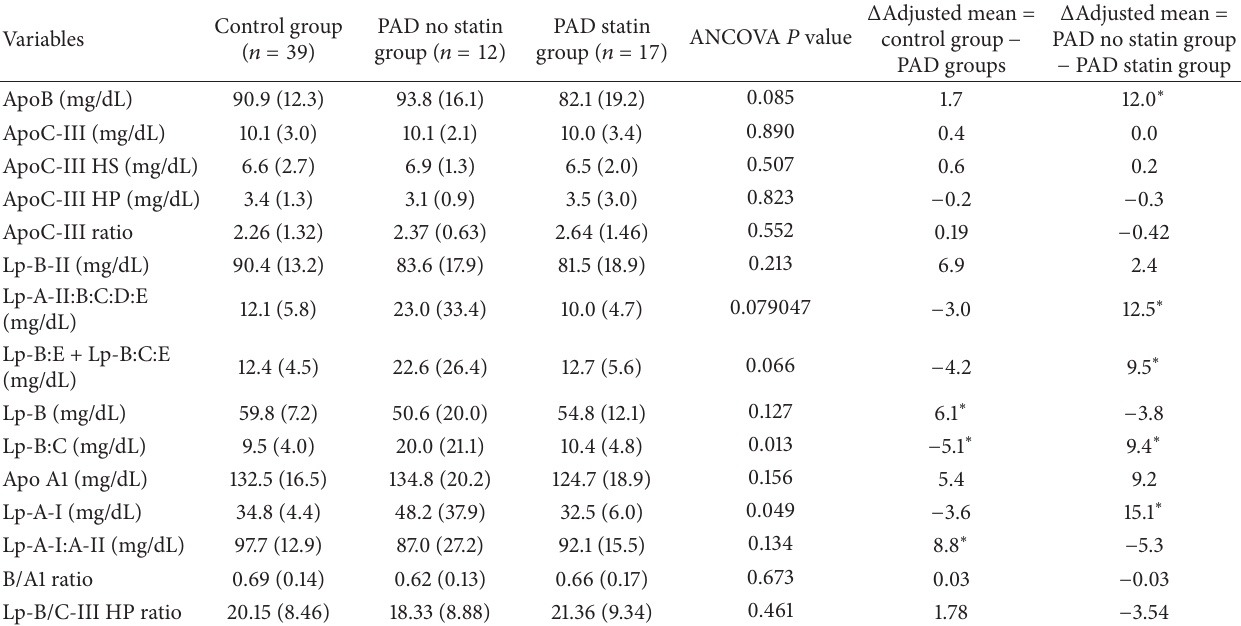
Table 3: Apolipoprotein measures of subjects with peripheral artery disease (PAD) and controls. Values are means (standard deviation).